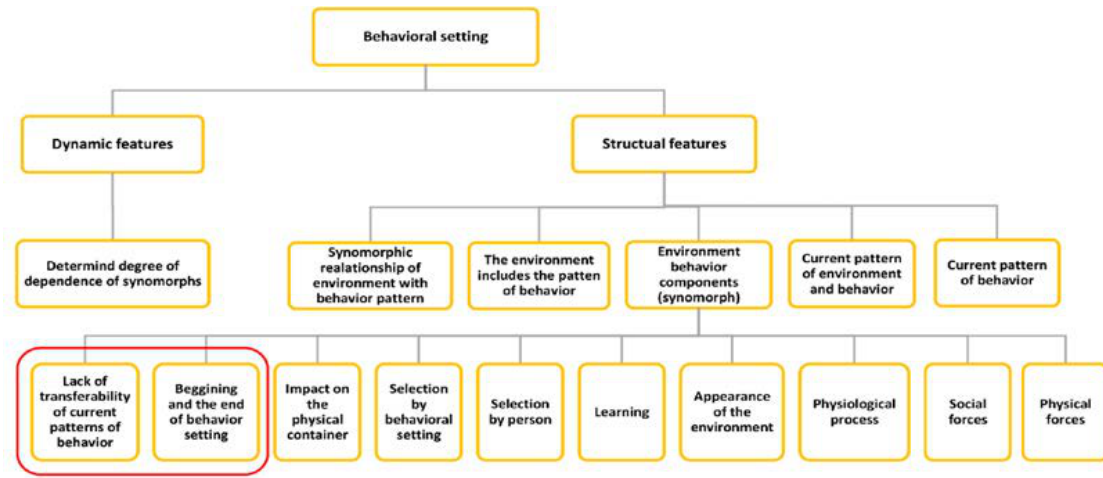
Fig . 2: Recognition of the behavioral settings of Barker theory from Schoggen’s point of view (Shoggen, Fig. 2: Recognition of the behavioral settings of Barker theory from Schoggen's point of view (Shoggen, 1989)